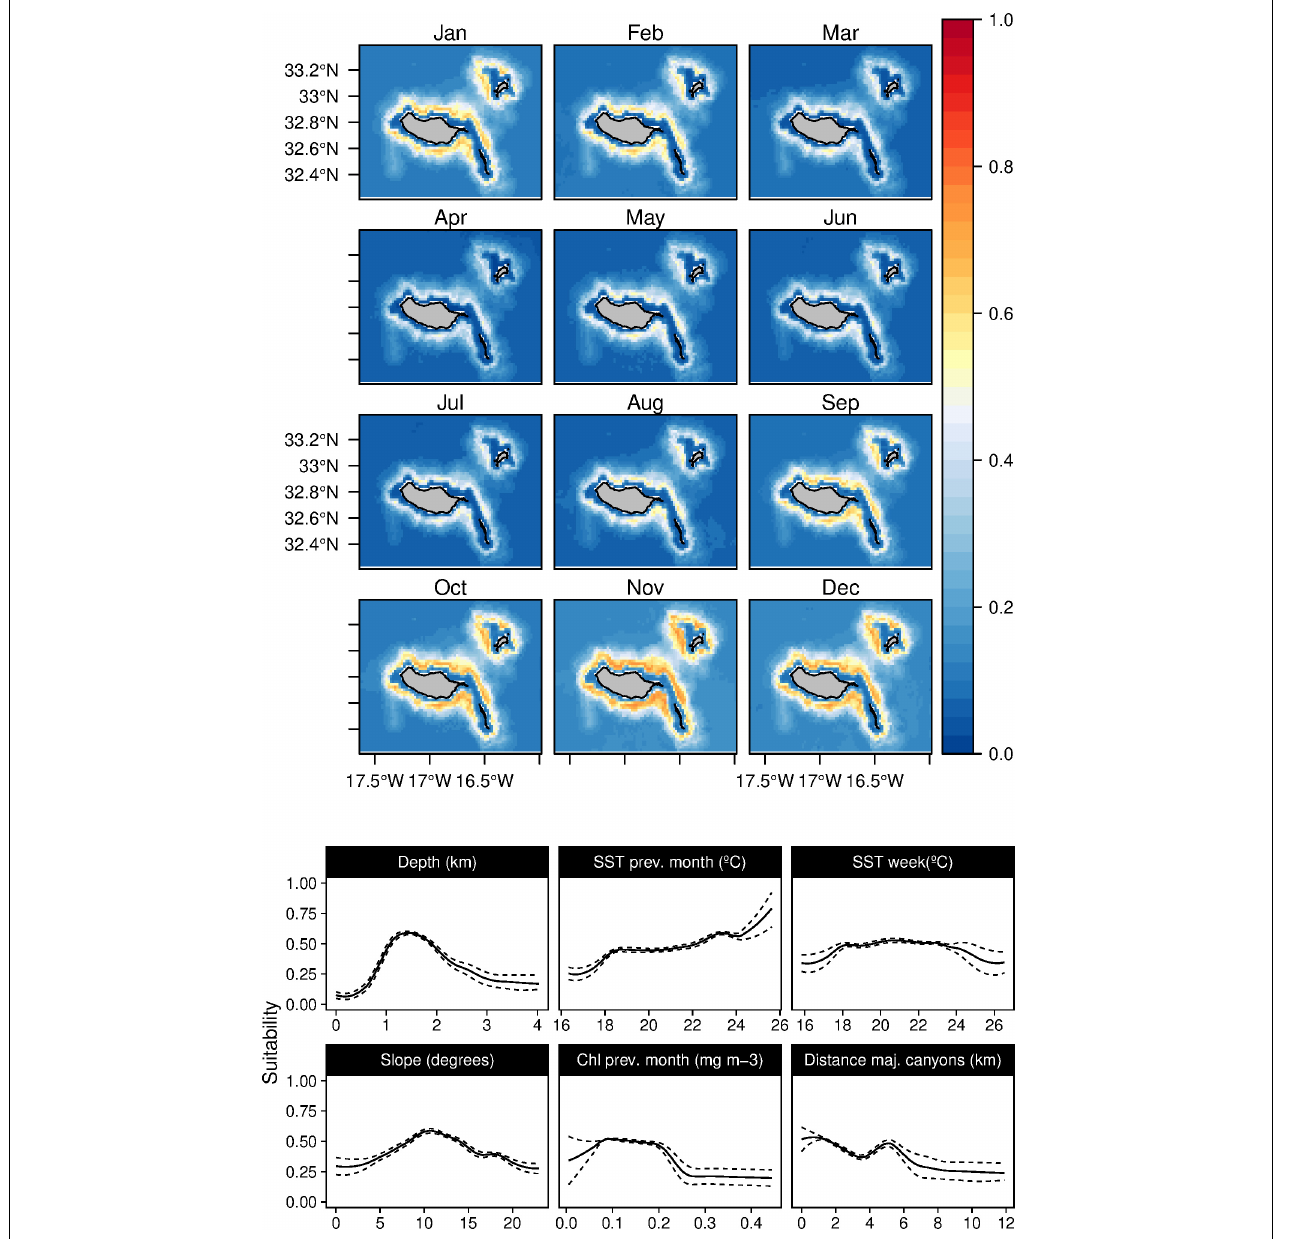
FIGURE 2 | Mean monthly suitability maps (above) and smoothed response curves with standard deviation (below) in the Madeira archipelago for Globicephala macrorhynchus for the “8-days” models. In the maps, red represents more suitable and blue less suitable. Responses curves are ordered by percent contribution of the environmental